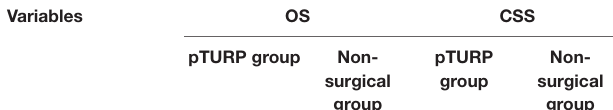
TABLE 3 | Multivariate COX analysis for patients in the matched